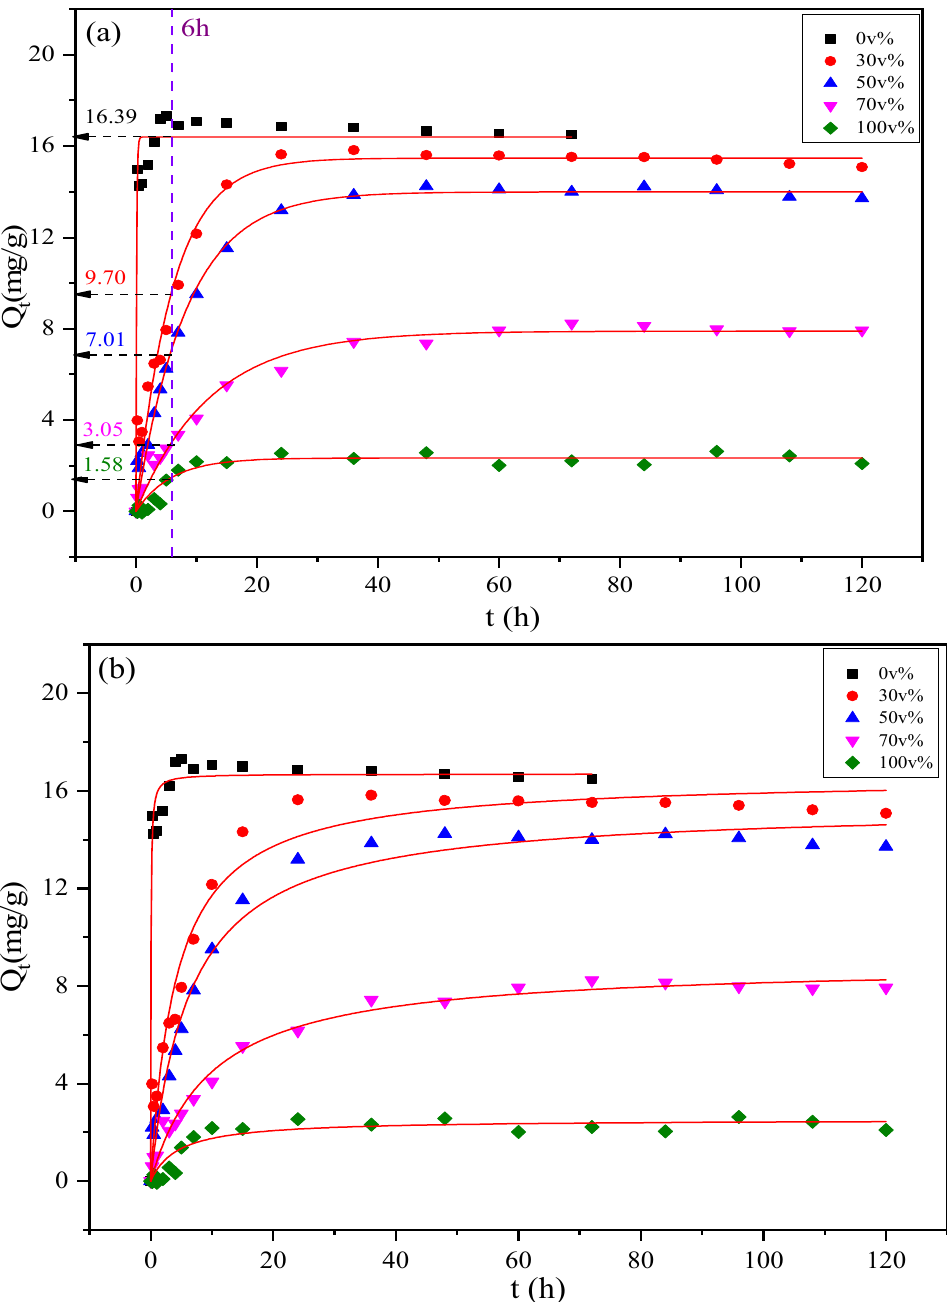
Figure 2. Adsorption kinetic models: ( a ) pseudo-first-order kinetic model; ( b ) pseudo-second-order kinetic model.